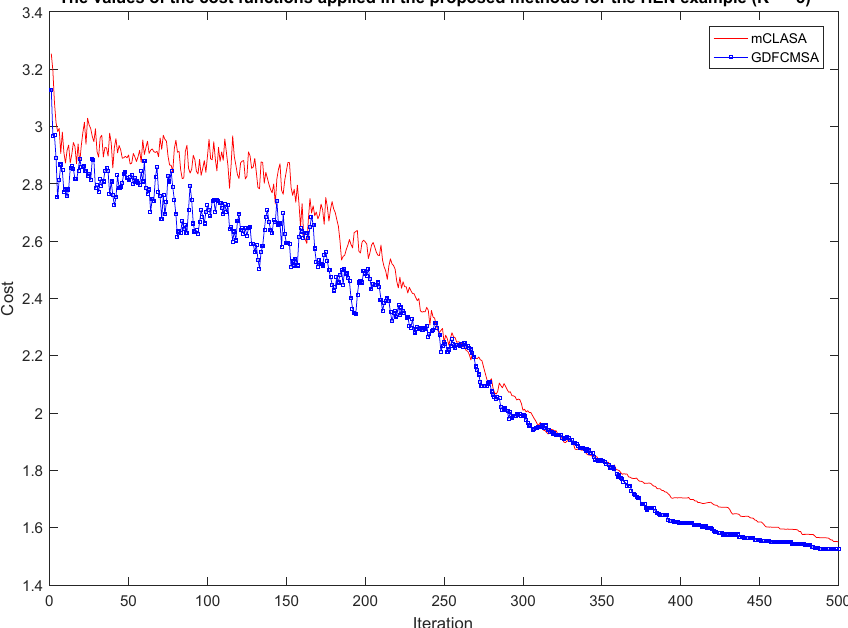
Figure 6. Analysis of the convergence with regard to the proposed methods in the case of the HEN. The colour red denotes the method mCLASA while the colour blue denotes the method GDFCMSA. It is clearly visible that the value of maxiter should be high because the methods also converge after 500 iterations. GDFCMSA provides a slightly better